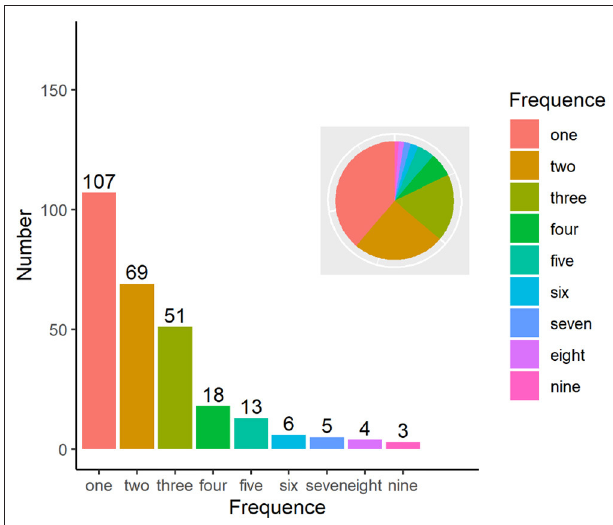
FIGURE 2 | Times of psychological consultation.